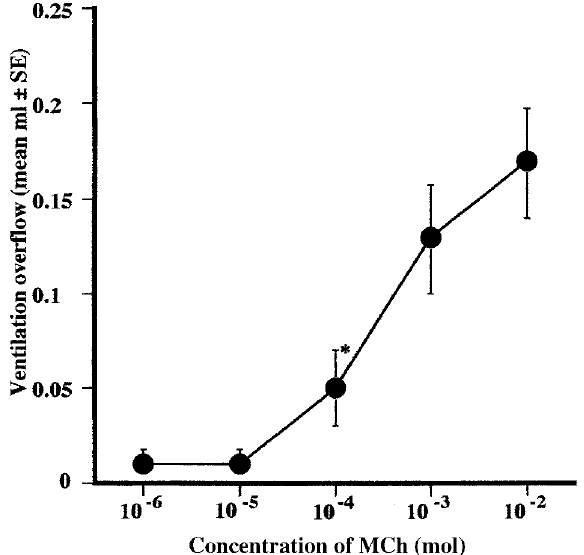
FIG. 2. Influence of MCh on bronchial responsiveness in non- sensitized mice. Each data item is the mean ± SE of five